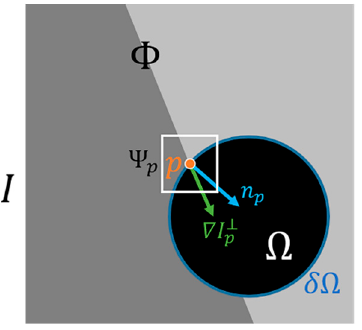
Figure 1. Notation diagram for Criminisi’s algorithm.